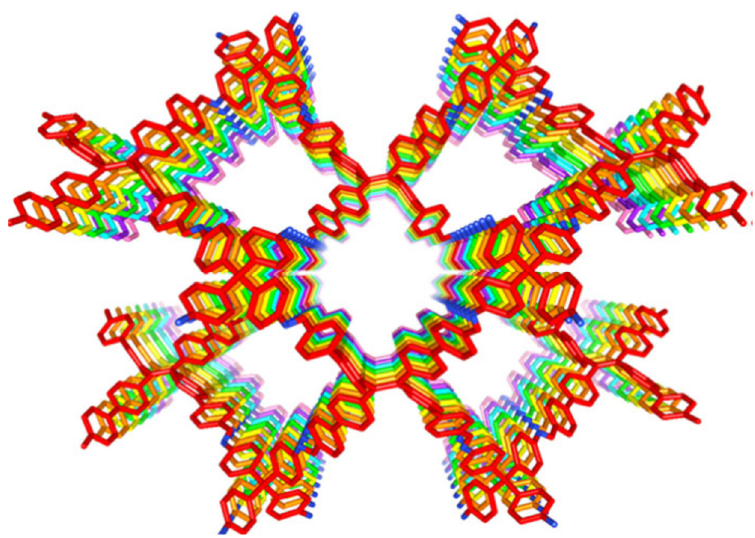
Figure 9. The porous structure of 3D-TPE-COF [44].